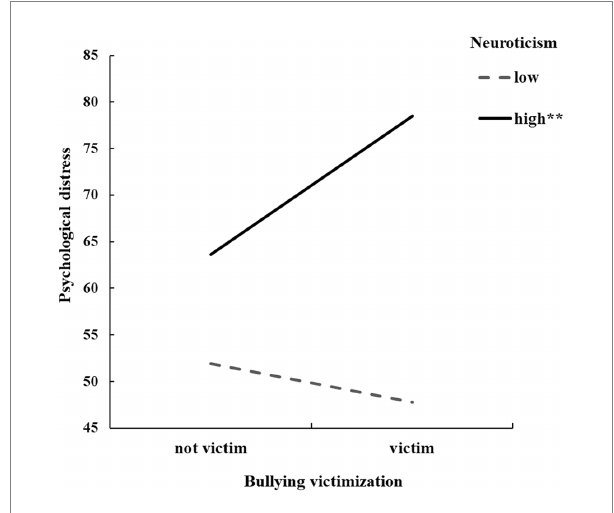
FIGURE 2 Interaction between bullying victimization and neuroticism in predicting psychological distress among adolescents. The y-axis of Figure 2 does not start at